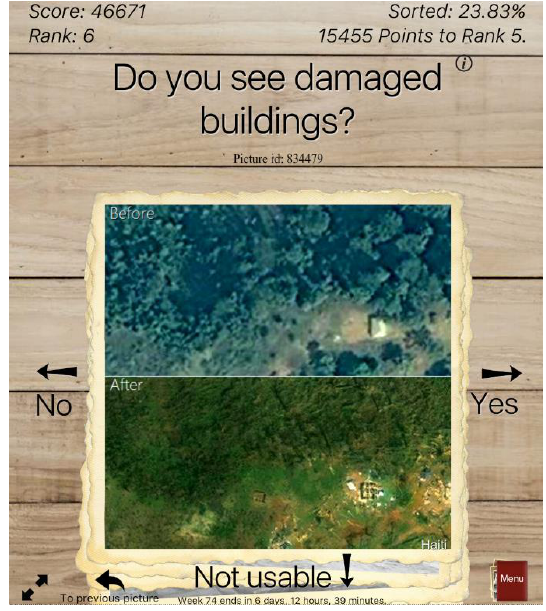
Figure 3. A screenshot of the Picture Pile tool used for assessment of building damage where a pre- and post-disaster image is presented to the